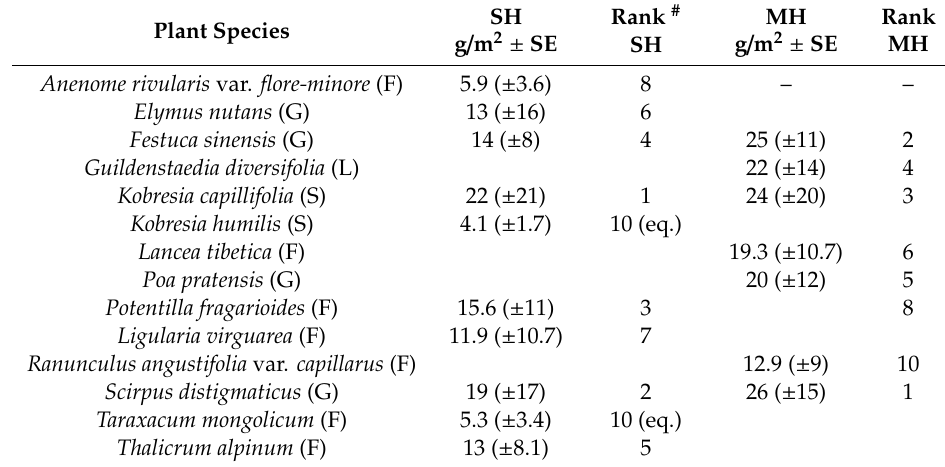
Table 2. The most commonly found forage species in grassland grazed under two di ff erent systems. SH refers to an area where a single household makes all the decisions about when, where and how long to graze a specific site and MH refers to an area under a community-based management scheme where cooperating households follow a plan, including scheduled bans to allow rest rotation grazing.